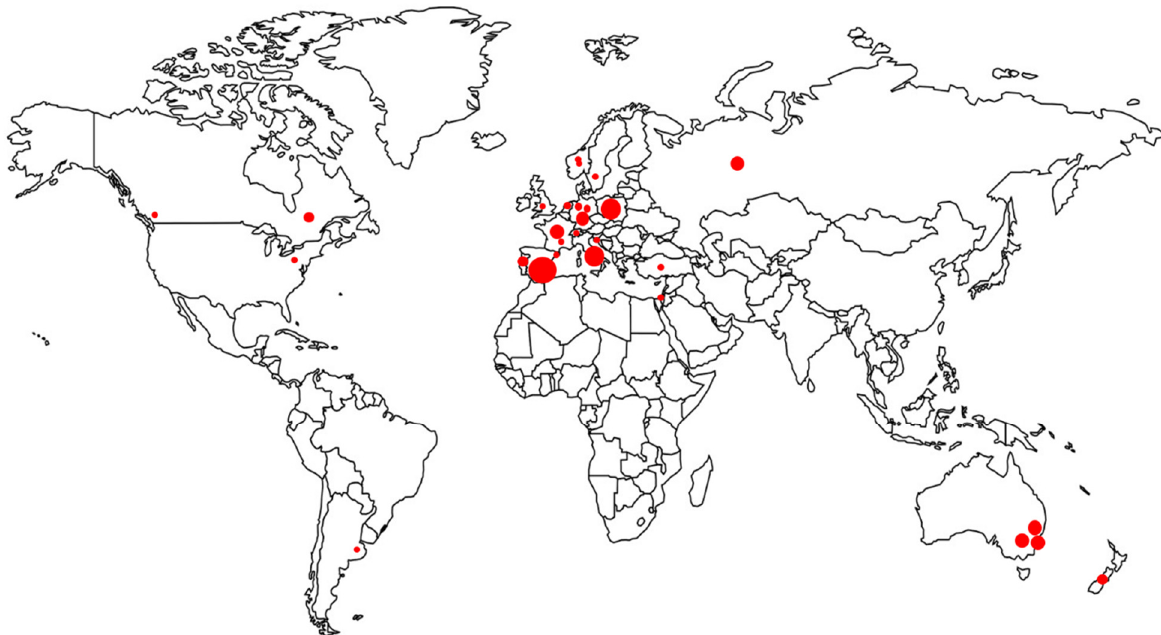
Figure 1. Geographic locations of participating centers and patient cohorts in SHARED. Each dot represents a participating center (local clinic or reference laboratory) where patient sample sequences were generated. For samples from randomized clinical trials or international consortia, the dots represent the participating countries. The size of the dot represents the relative number of samples (not to scale).